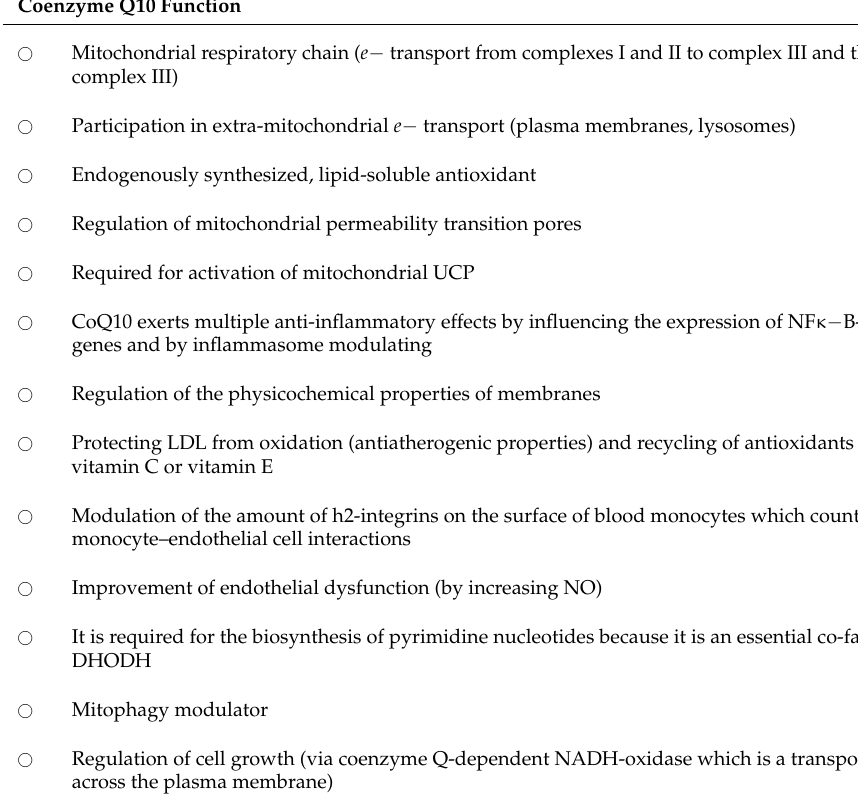
Table 1. Functions of coenzyme Q10 in the human body. Based on information from